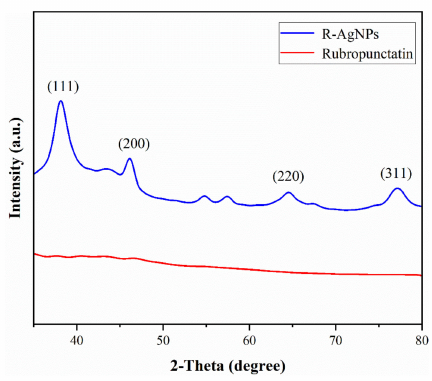
Figure 4. X-ray powder diffraction pattern of the R-AgNPs and rubropunctatin.